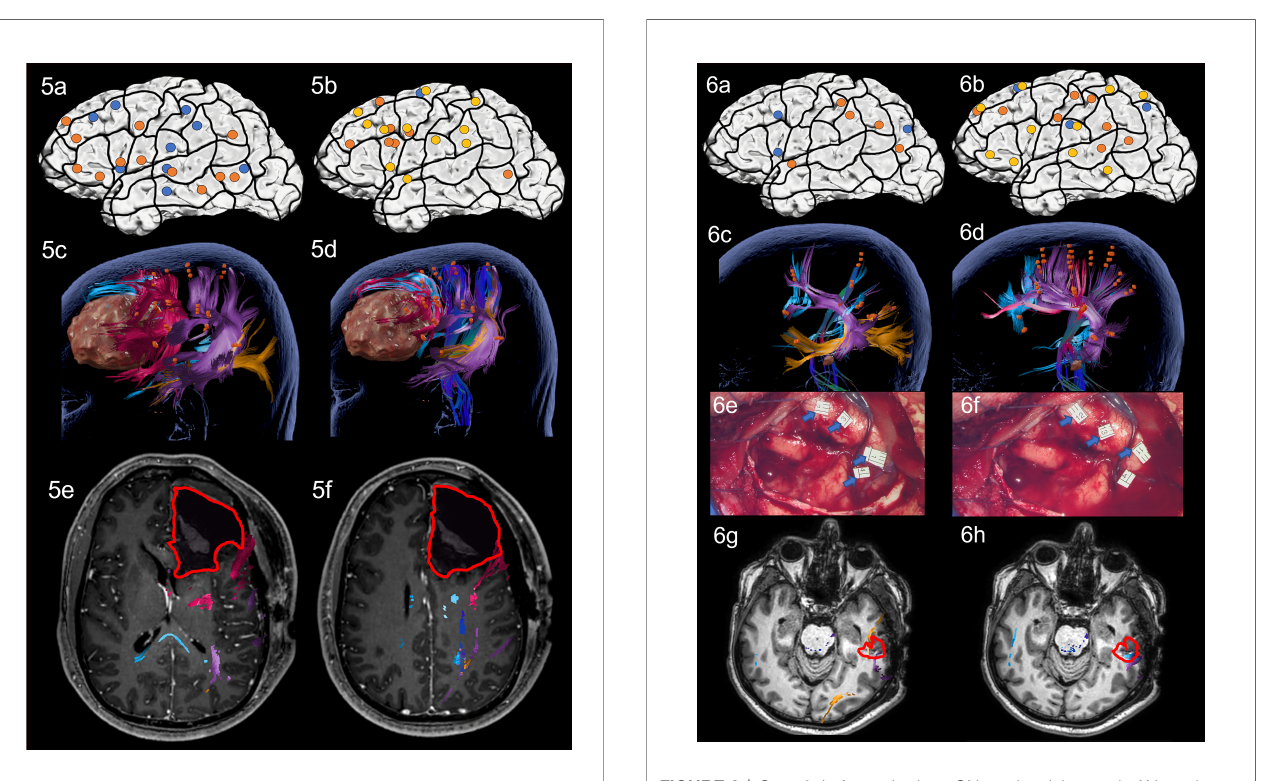
FIGURE 5 | Case 5. Left panels show ON results, right panels AN results. Panels (A, B) nTMS stimulation sites that induced errors; no response and hesitations in orange, semantic errors in yellow and performance errors in blue. Panels (C, D) Fiber tracking results including the lesion, nTMS cortical endpoints in orange and color-coded tracts with CNT in direction-coded, here dark blue, AF in purple, ILF in yellow, Frontal Aslant Tract in pink, and CF in light blue. Panels (E, F) Overlap of tracking and postoperative T1-weighted imaging after elastic fusion with the resection cavity marked in